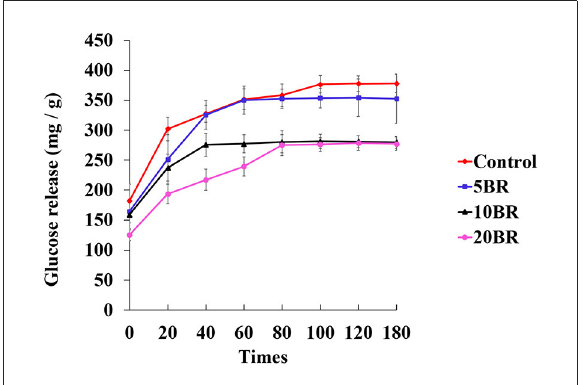
FIGURE4 In vitro starch digestion at different times for flaky rolls incorporated with different proportions of black rice flour.